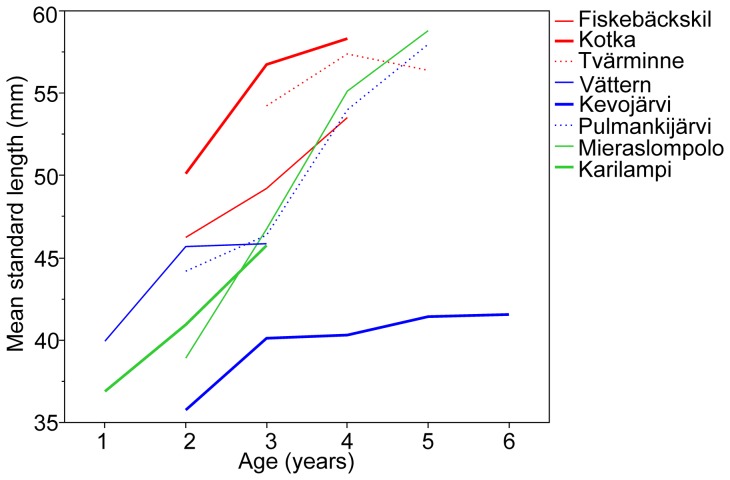
Mean standard length in different localities as a function of age.